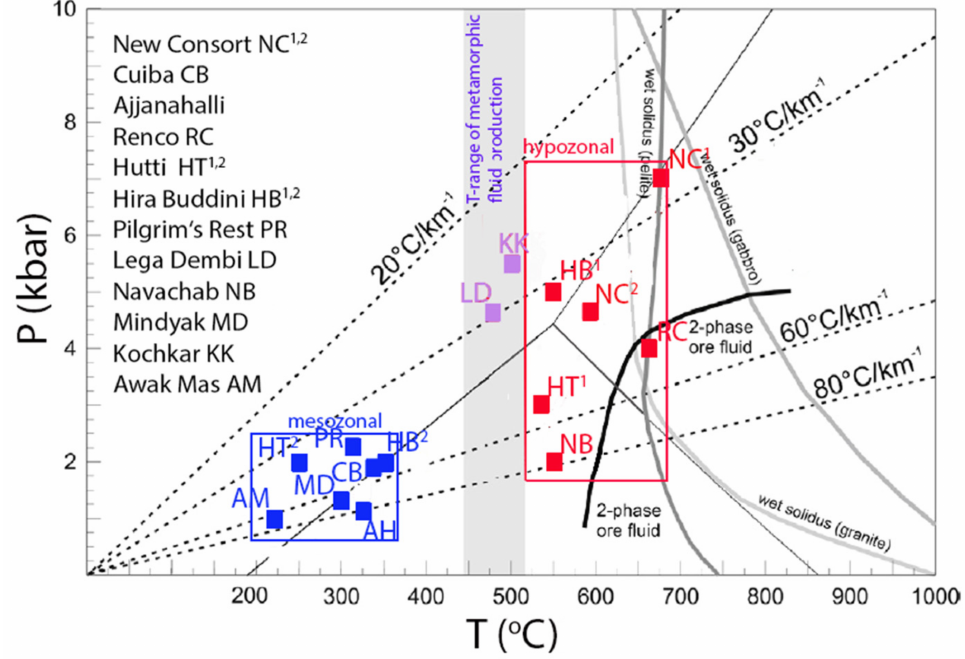
Figure 4. Pressure-temperature conditions of mineralization (modified from [1]). The fields for hypozonal and mesozonal orogenic gold deposits are delineated. Also included are geothermal gradients as well as wet solidi for granite, pelite, and gabbro. Errors are the same as in Figure